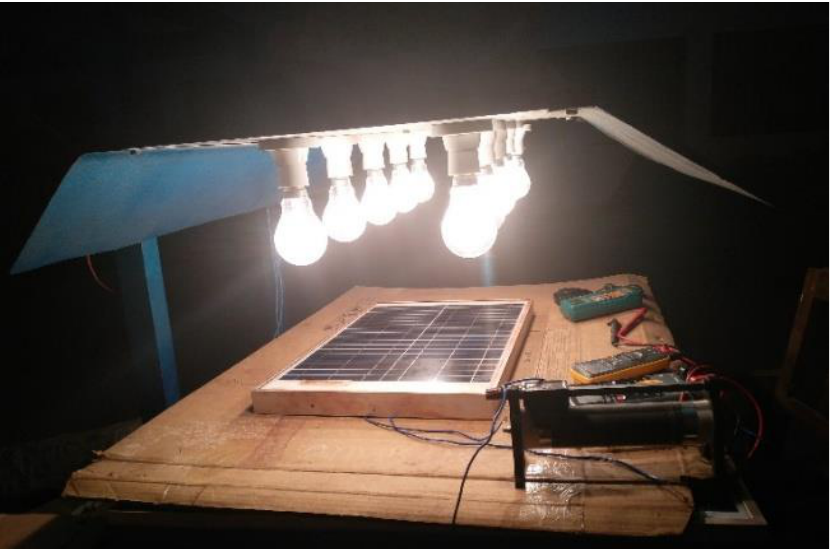
Figure 1. Experimental set-up.